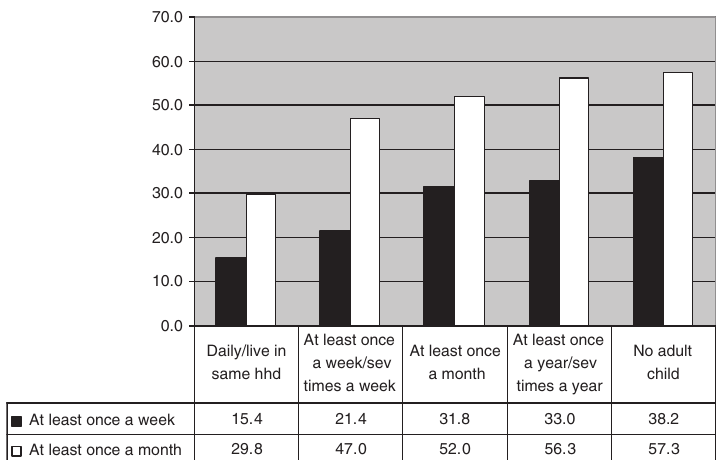
Figure 3. Proportion seeing sibling at least weekly/monthly by frequency of contact with adult child. n (cid:4) 7131 (71.7%), p B 0.0005.